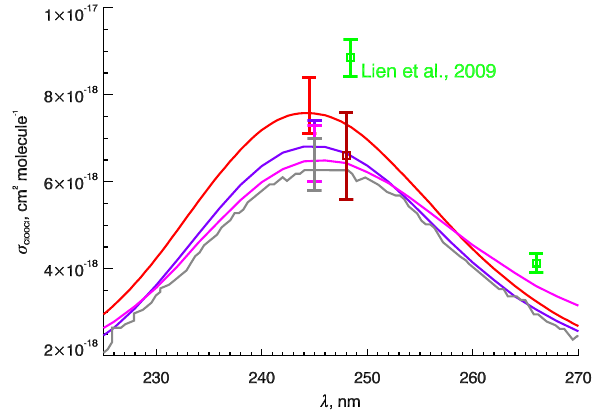
Fig. 2. Peak close-up for Fig. 1a. The colours of lines and squares correspond to the absorption cross sections and photolysis cross sections plotted in Fig. 1a,